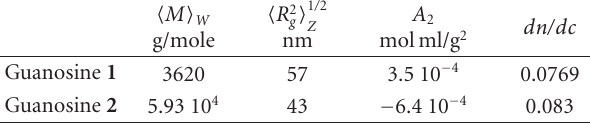
(cid:4) 1 / 2 , and (cid:3) M (cid:4) W g Z